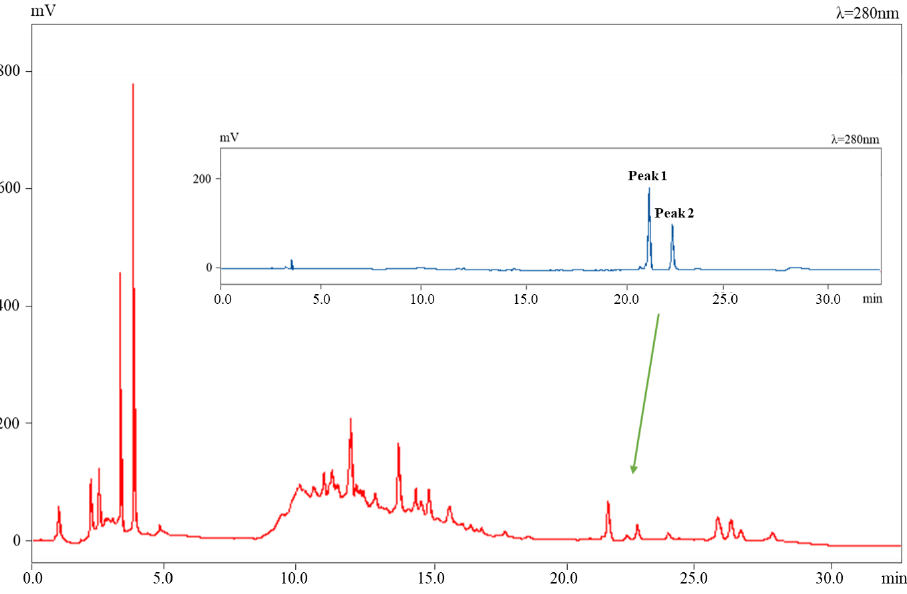
Figure 2. UHPLC-UV- Vis (λ = 280 nm) chromatographic profile of the extract (Peak 1: Capsaicin Figure 2. UHPLC-UV-Vis ( λ = 280 nm) chromatographic profile of the extract (Peak 1: Capsaicin standard; Peak 2: Dihydrocapsaicin standard). standard; Peak 2: Dihydrocapsaicin standard).